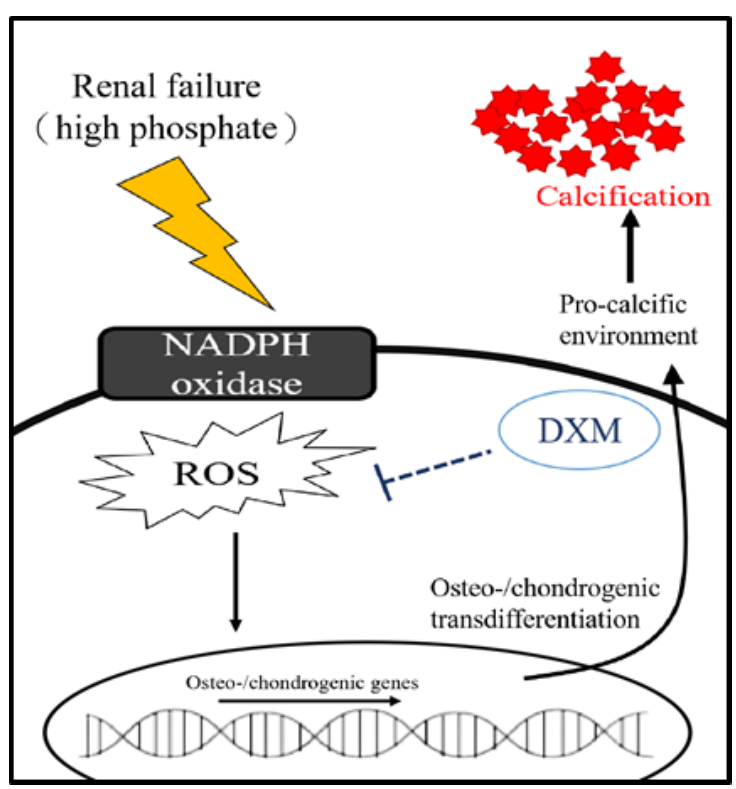
Figure 7. Schematic representation of the effects of dextromethorphan attenuating vascular calcification by attenuating ROS production and vascular smooth muscle cell osteoblast transdifferentiation of hyperphosphatemia.